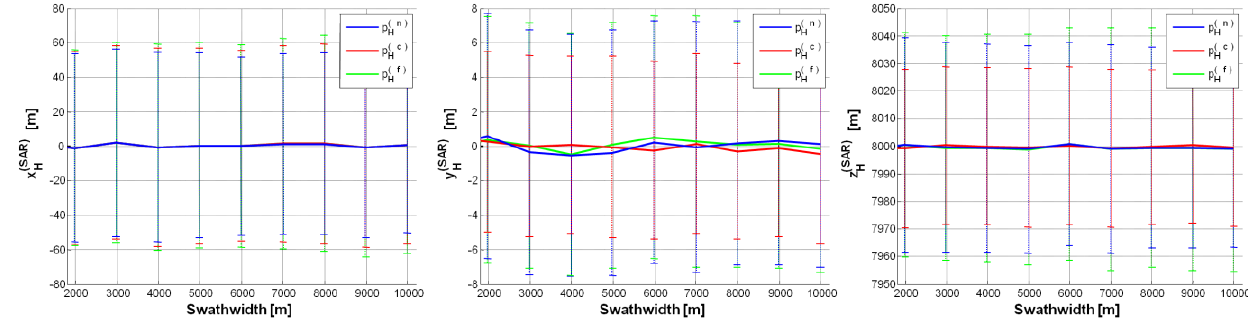
p , ( ) c p ): H H , Δ h = 0.5%, Δ p = ±2. Error (on each